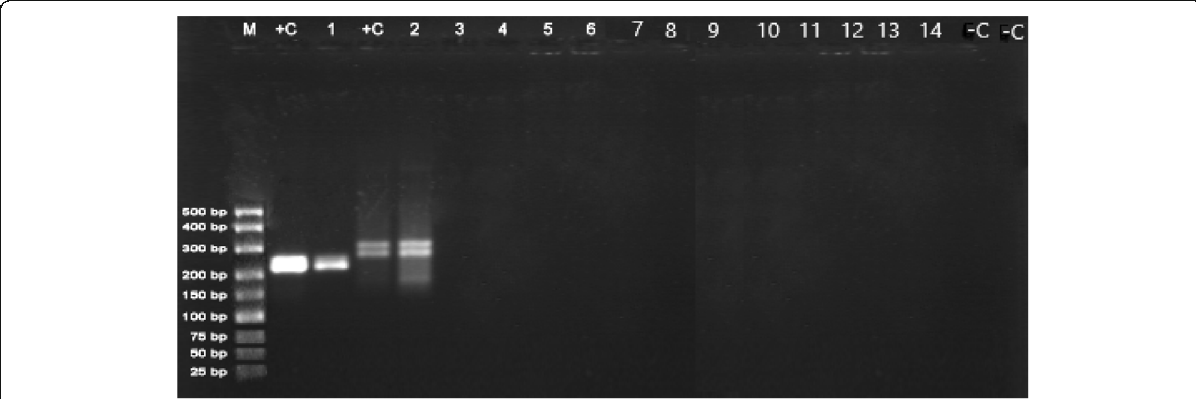
Fig. 3 Different PCR products representing human origin of adulteration in different beef meat products. Lane M is 25 – 500 bp ladder or size marker. Lane 1 is for positive control of TP0X short tandem repeat; lane 2 is a hand-made kofta sample with positive TP0X. Lane 3 is a positive control sample amplified with D18S51 primers, and lane 4 is a positively amplified same kofta sample. Lanes 5 and 6 were another negative kofta sample for both loci. Lanes 7, 8, 9 and 10 were negative amplification sausage samples for the two primer pairs. Lanes 11 and 12 were beef burger negative sample for both loci and lanes 13 and 14 represented negative luncheon sample for the two loci. − C (lane 15) and − C (lane 16) are negative controls for TP0X and D8S51, respectively. Positive result was indicated by one or two bands of 216 – 264 bp size range for TP0X